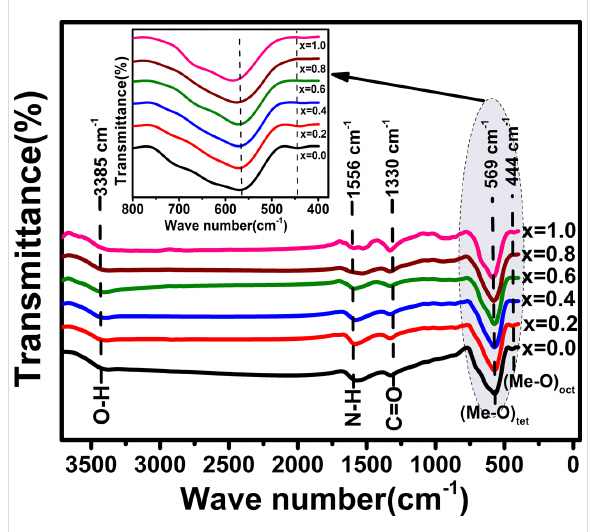
Figure 5: FTIR spectra of Co x Fe 3 − x O 4 nanoparticles with x = 0.0, 0.2, 0.4, 0.6, 0.8 and 1.0. The inset is the part of the spectra at frequencies below 1000 cm − 1